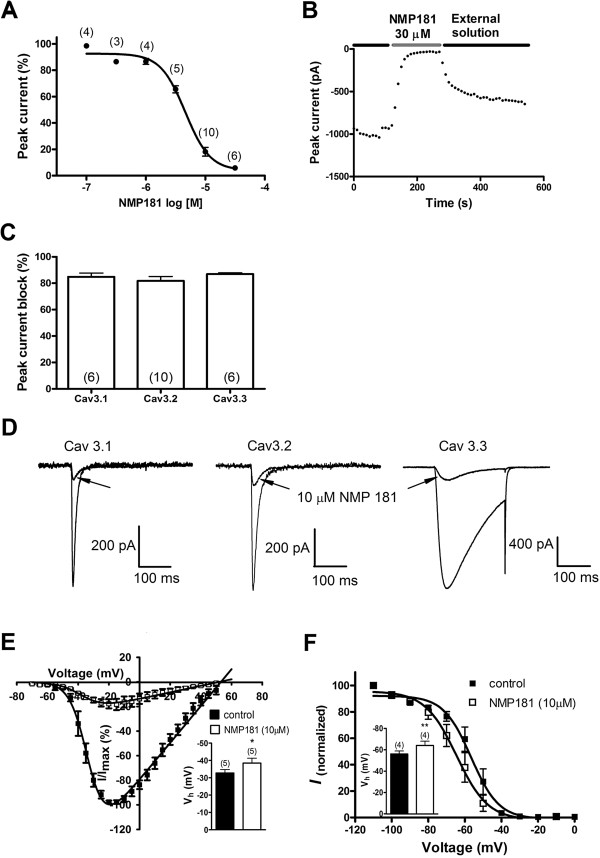
Pharmacological and biophysical properties of NMP-181 block of T-type calcium channels. (A) concentration dependence of NMP-181 inhibition of the CaV3.2 peak current amplitude. The data were fitted with a Hill equation. The half-maximal inhibitory concentration (IC50) from the fit was 4.6 μM and the Hill coefficient was 2.1. Numbers in parentheses reflect numbers of experiments for each concentration point. (B) representative time course of the development of and recovery from NMP-181 (30 μM) inhibition. (C), NMP-181 (10 μM) did not show selectivity on CaV3 channels, as illustrated in the histogram and (D) representative traces from NMP-181 inhibition on CaV3.1, 3.2 and 3.3 currents. Statistical significance was determined by one-way ANOVA followed by a Dunnett’s test, when the data were compared to those from CaV3.2 group. (E) normalized current–voltage relations of CaV3.2 current before and after application of 10 μM NMP-181. The half-activation potentials were -32.7 ± 2.0 mV and -38.4 ± 2.8 mV before and after application of NMP-181, respectively (inset, P < 0.05, paired t test). (F) steady-state inactivation curve obtained from CaV3.2 channels before and after application of 10 μM NMP-181. The half-inactivation potentials were -56.0 ± 2.8 mV and -64.1 ± 4.0 mV before and after the treatment with NMP-181, respectively (inset, P < 0.01, paired t test).